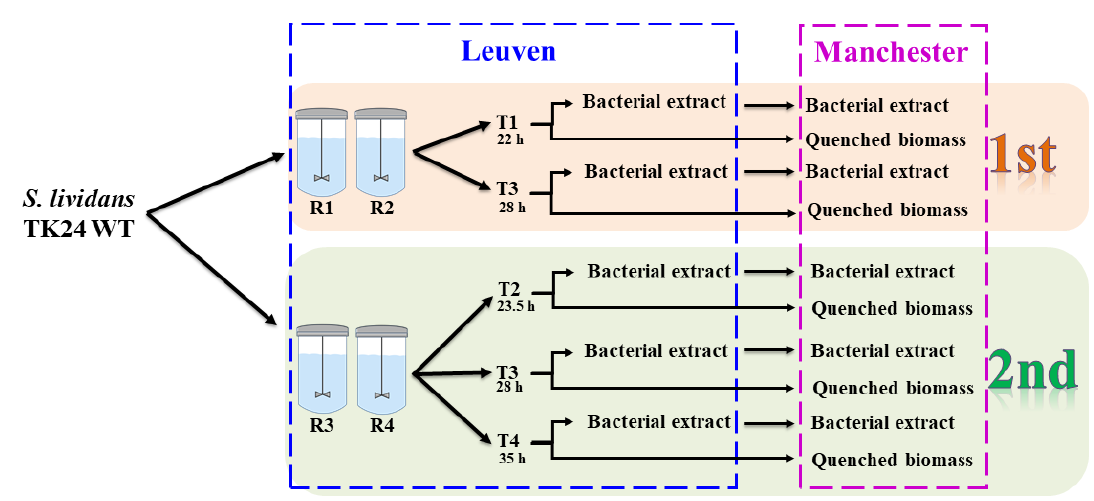
Figure 1. Overview of the experimental design. R = reactor and T = time of